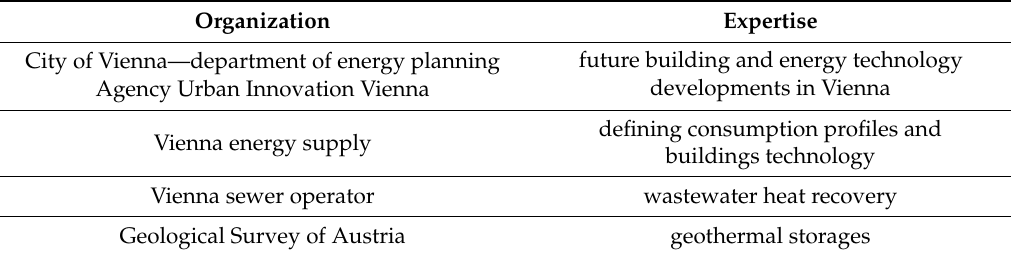
Table 1. Advisory board organizations and functions in the project.